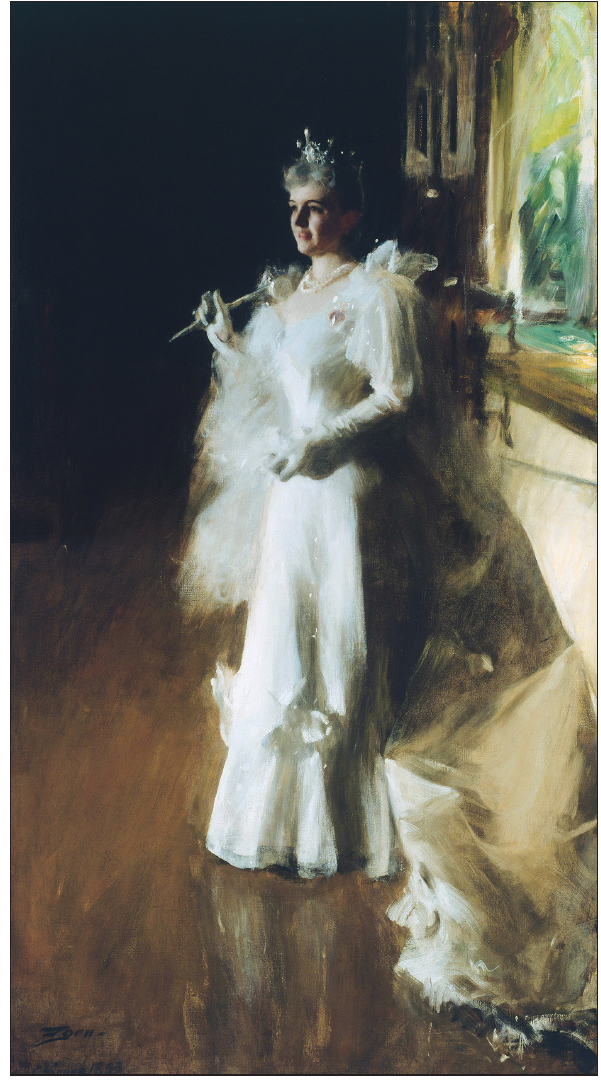
Fig. 6 : Anders Zorn, Mrs Potter Palmer , 1893, oil on canvas, 258 × 141.2 cm, Chicago Art Institute. Wikimedia